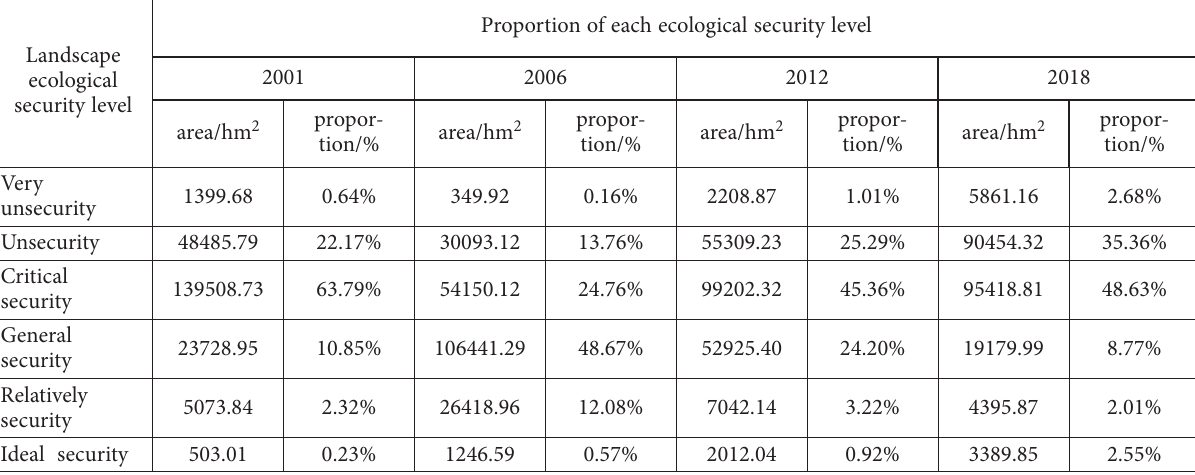
Table 5. Landscape ecological security grades and their cover area in Zhong County from 2000 to 2018